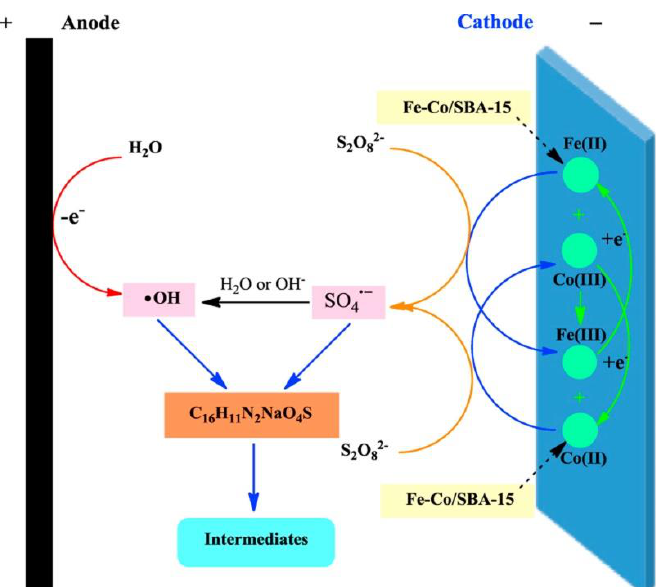
Figure 4. The mechanism of EC/Fe-Co/SBA-15/PDS system. Reprinted with permission from ref [122]. Copyright 2014 Elsevier B.V.